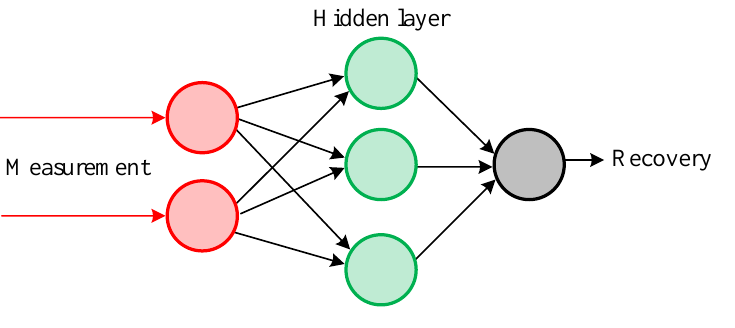
Figure 2. Example neural network